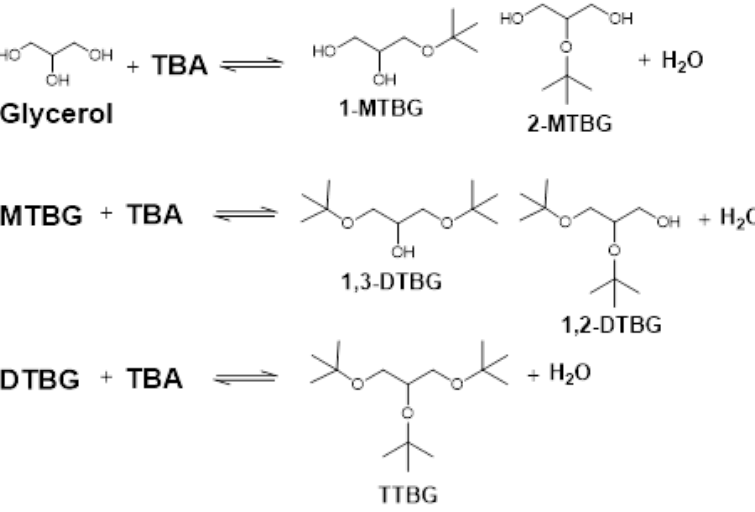
Figure 18. Glycerol etherification reactions with